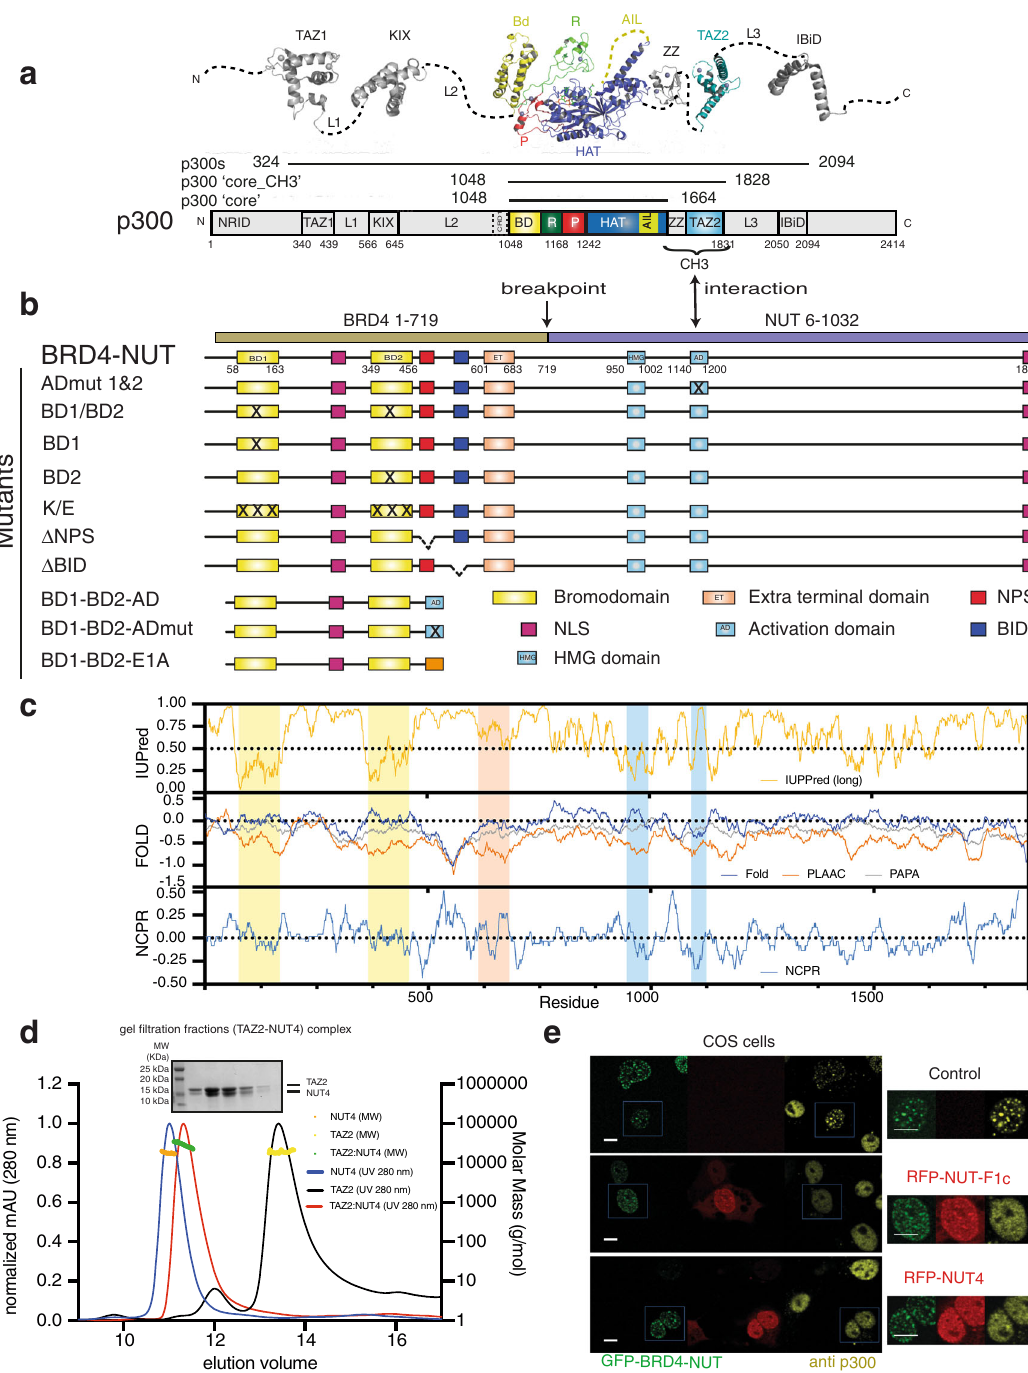
PAGE analysis of the peak fractions of the TAZ2-NUT4 complex is shown. The experimentwasrepeatedtwicewithconsistency. e Competitionanalysis:Cos7cells were transfected with constructs expressing GFP-BRD4-NUT (green) alone or co- transfectedwithRFP-NUT-F1candRFP-NUT4(red).Immuno fl uorescencewithanti- p300 antibody was used to visualize endogenous p300. Scale bars, 10 μ m. The experiment was repeated three times with